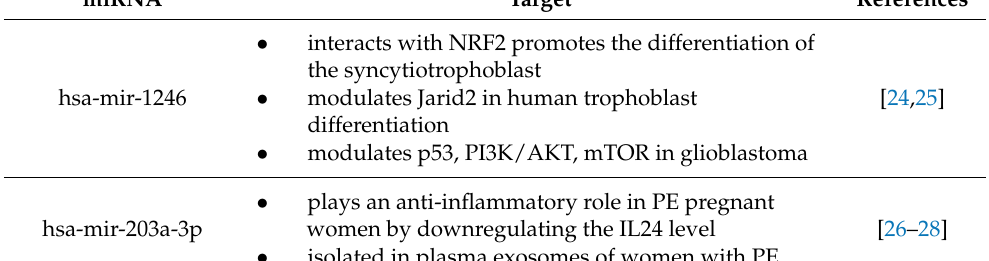
Figure 4. Differentially Expressed of plasma-specific miRNAs . Barplot shows the upregulated unique miRNAs in plasma. The expression levels are expressed as log Fold Change (log2FC).